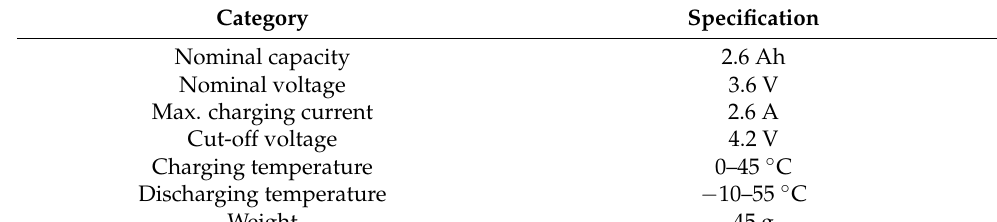
Table 4. Initial electrochemical model parameters of ICR18650-26J ba tt ery.